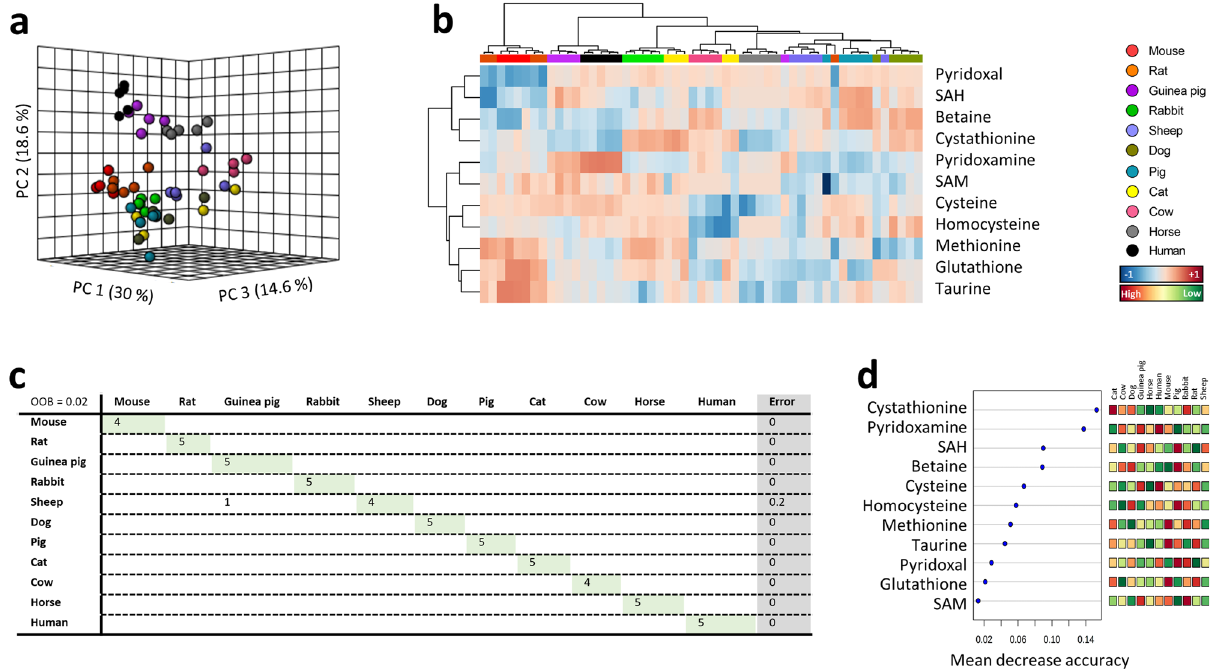
Fig. 1 Multivariate statistics reveals a species-speci fi c methionine plasma pro fi le. a Principal component analyses (PCA) representation of methionine- related metabolites. X: Principal component 1 (PC1); Y: Principal component 2 (PC2); Z: Principal component 3 (PC3). b Hierarchical clustering of individual animal samples according to metabolite abundance. c Random forest (RF) classi fi cation algorithm. d VIP scores for RF. Data values are obtained from four (mice and cows), fi ve (rats, rabbits, guinea pigs, sheep, dogs, pigs, cats and horses) or six (humans)